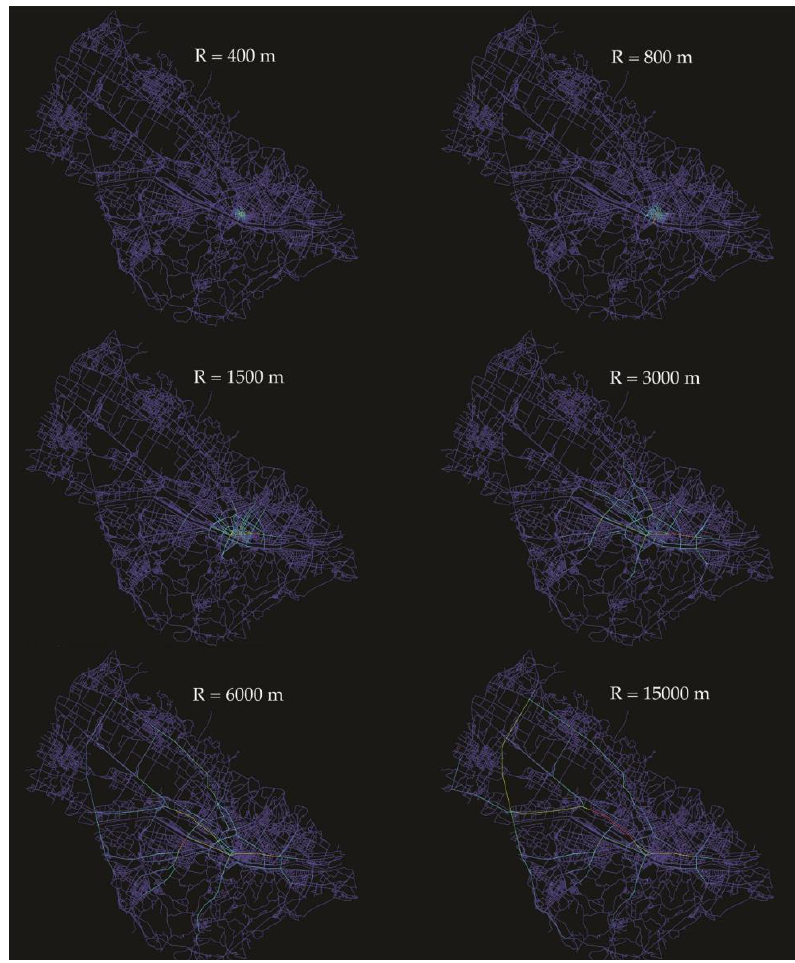
Figure 9. Distribution of choice value in Florence for different values of metric radius.